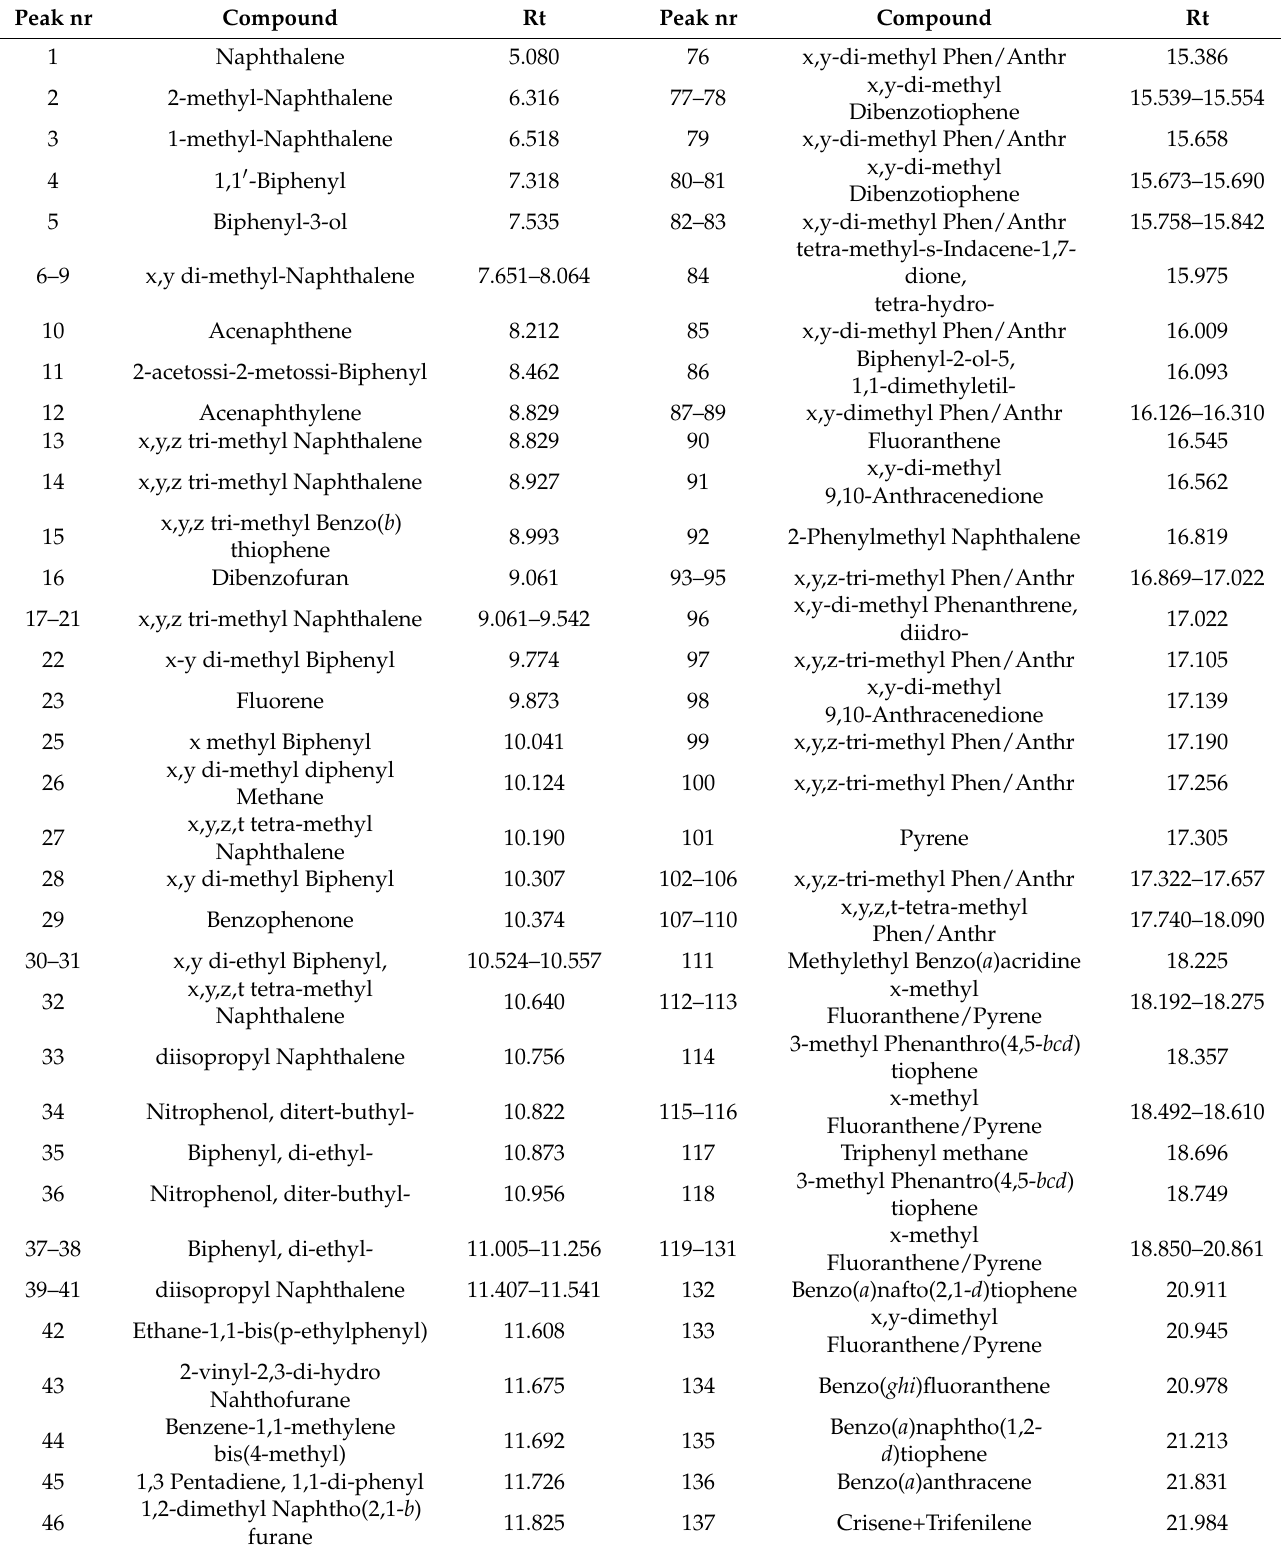
Table 2. Identity list of PACs in honeybee sample from monitoring station 1 and related chromato- graphic retention times